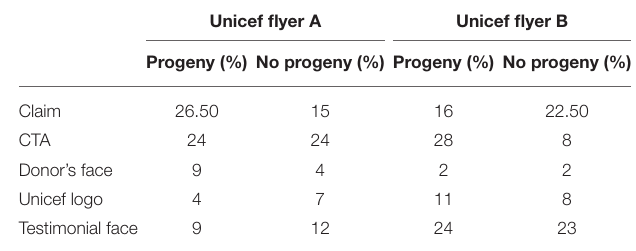
TABLE 2 | Time spent (%) among five different areas of interest in Unicef flyers.